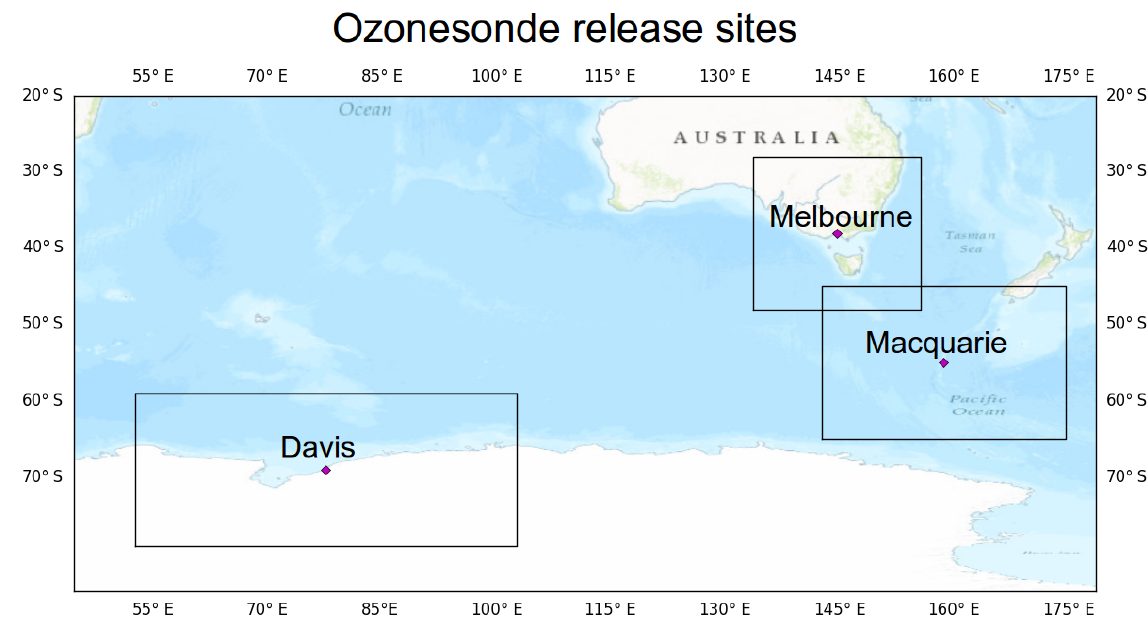
Figure 1. Ozonesonde release sites and the regions used to examine STT effect on tropospheric ozone